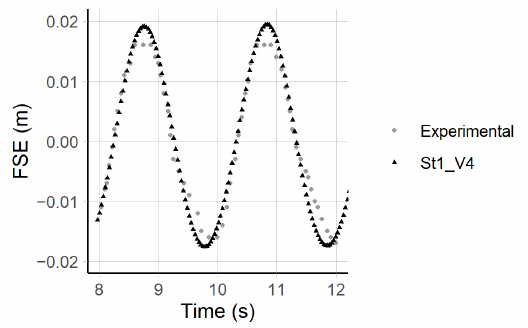
Figure 4. Free Surface Elevation (FSE) measured at 12.2 m of the inlet of the wave tank.